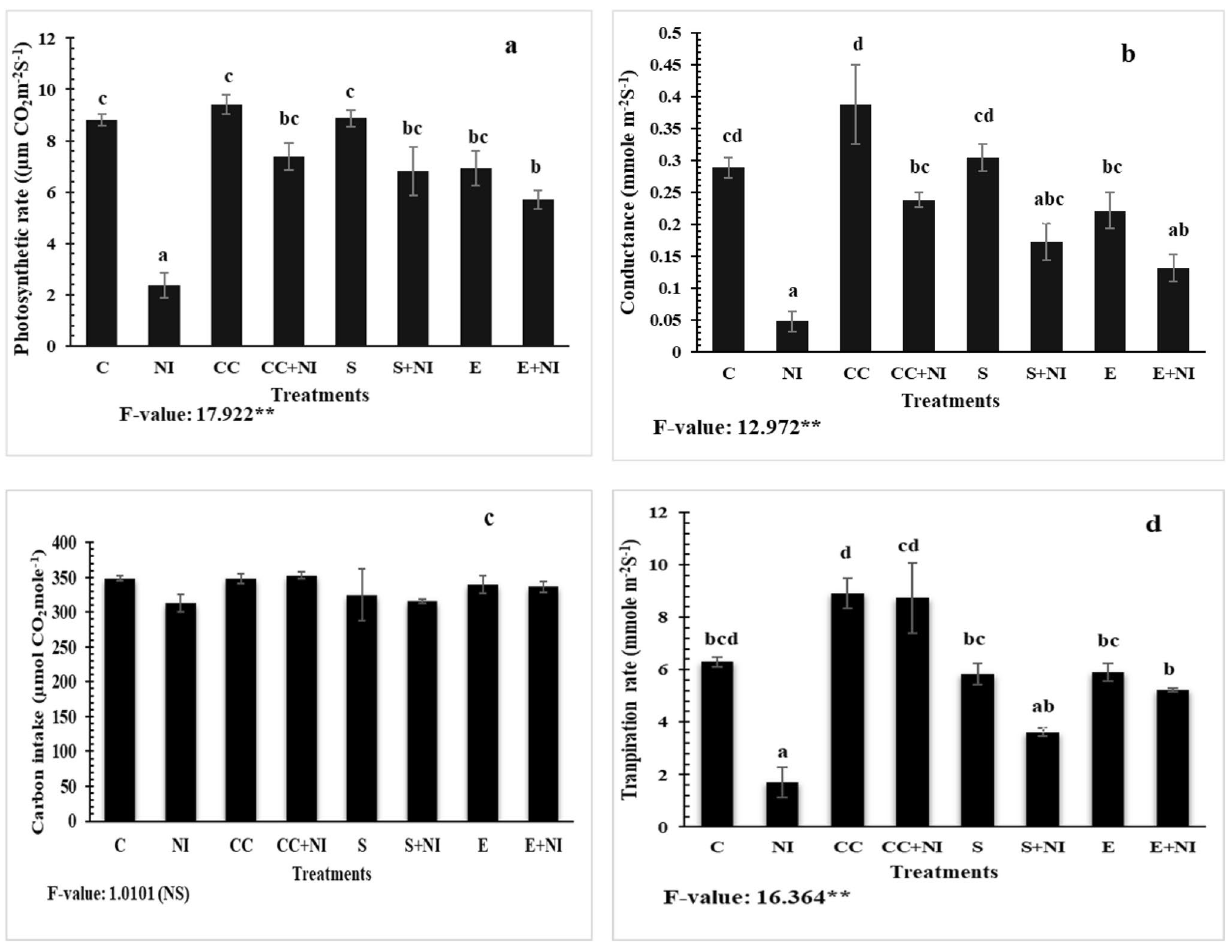
Figure 3. ( a-d ) Gas analysis parameters ( a ) Photosynthetic rate; ( b ) Conductance; ( c ) Carbon intake; ( d ) Transpiration rate in M. incognita inoculated 60 days old tomato plants under treatment with S. hydrogenans strain DH-16. Different treatments are represented as C (control), NI (nematode inoculated), CC (culture cells), CC + NI (culture cells + nematode inoculated), S (supernatant), S + NI (supernatant + nematode inoculated), E (crude extract), E + NI (crude extract + nematode inoculated). Results are given in mean ± standard error and F-value ** indicates significance at p ≤ 0.01 and ns indicates non-significant difference as per Tukey’s test. Different letters a, b, c, d represent significant difference among treatments and same letters represent no significant